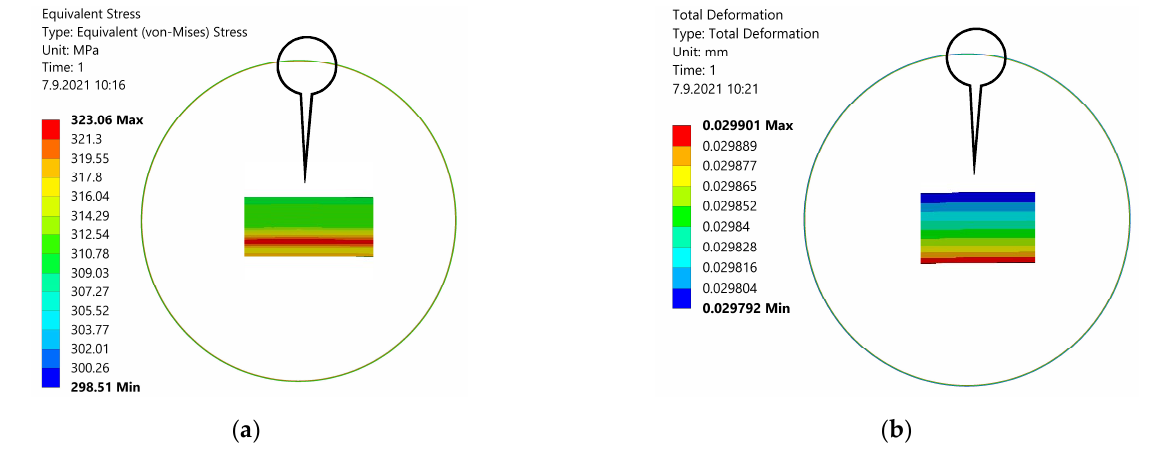
Figure 7. Mechanical analysis of the sleeve slid onto the rotor: ( a ) Von Mises stress; ( b ) total deformation.